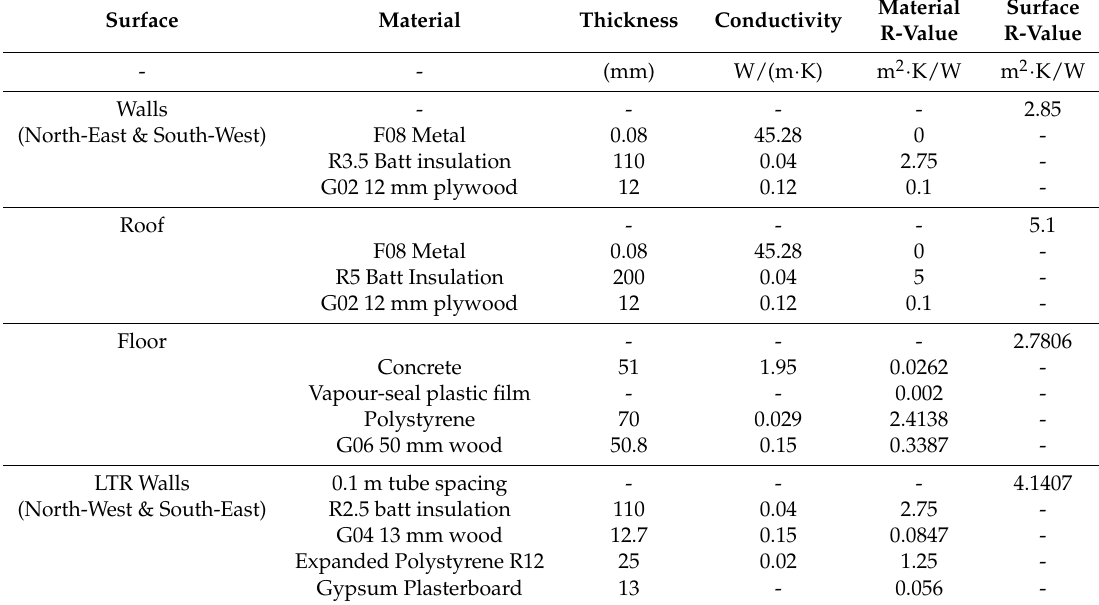
Table 1. Materials for the surfaces for the 60-m 2 experimental